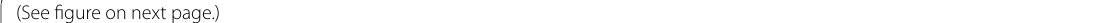
(See figure on next page.) Fig. 3 GC-MS analysis of compounds extracted from supernatant of Alcaligenes sp. CT10 culture. a Total ion chromatograph. Peaks with matched molecules are numbered. b MS spectra of individual compounds indicated. c An inhibitory compound to ZS1 from CT10. NMR analysis indicates that the compound 1 is the cyclodipeptide